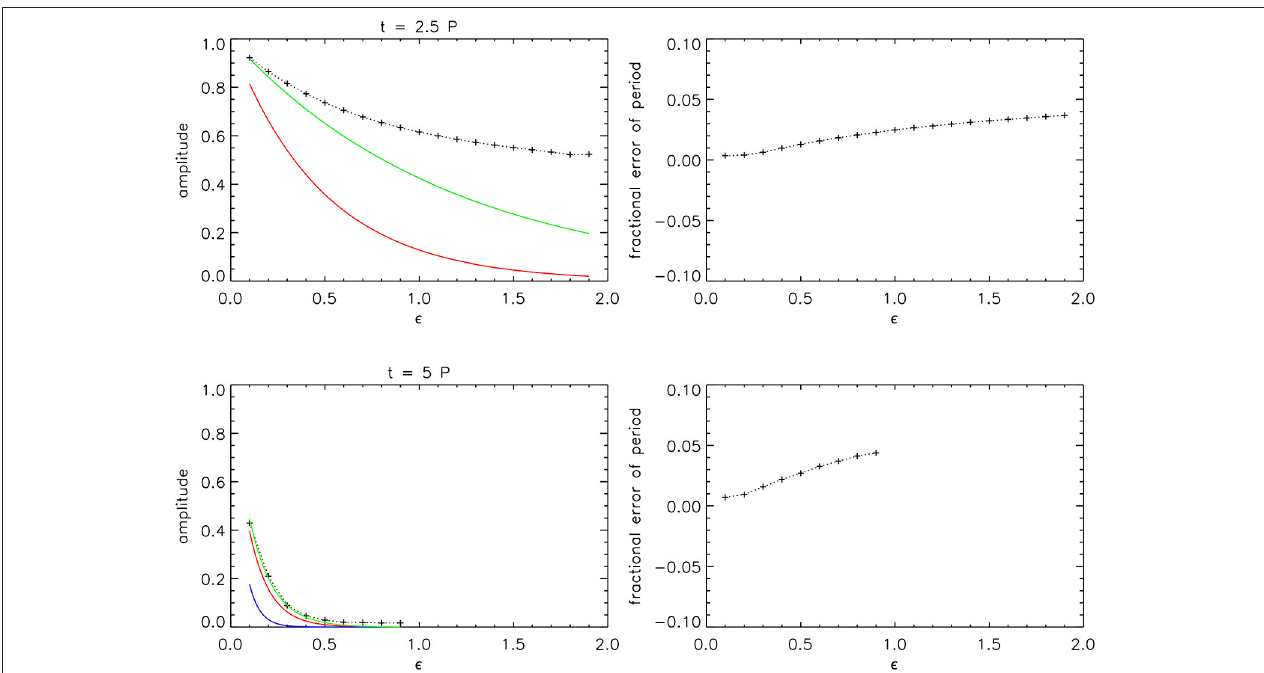
FIGURE 4 | Dependence of the damping of the kink oscillation on the inhomogeneous layer width ǫ . The top panels show results for ζ = 2 and the bottom panels for ζ = 7. The left panels show the kink oscillation amplitude (plus symbols) taken at a fixed time ( t = 5 P or 2.5 P ) The colored lines show the estimates based on the general damping profile (green), Gaussian damping profile (blue), and exponential damping profile (red). The right panels show the variation of the period of oscillation compared with the theoretical value P k